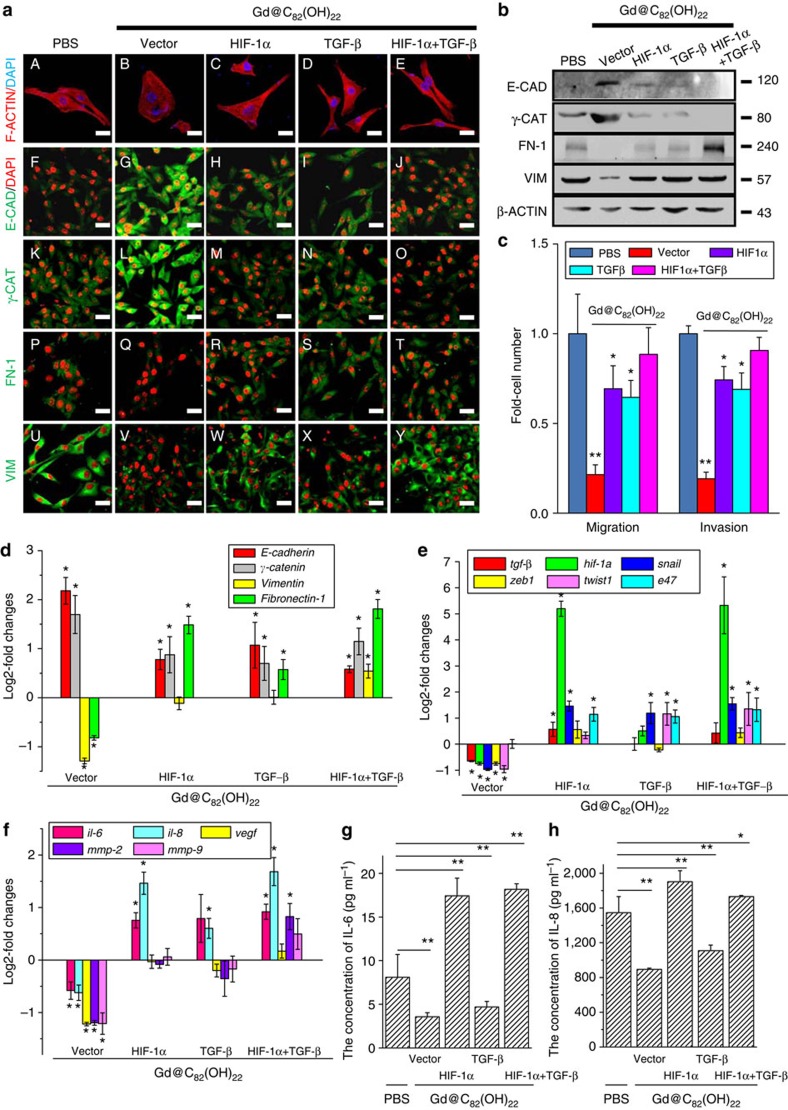
Gd@C82(OH)22 impaired EMT by inhibition of TGF-β and HIF-1α expression under hypoxia.MDA-MB-231 cells were transfected with hif-1α expressing plasmid and/or treated with 20 ng ml−1 TGF-β with further culture in the presence of Gd@C82(OH)22 or PBS under hypoxia for 10 days. (a; A-E) F-ACTIN cytoskeleton of cells (scale bar, 12.5 μm). Immunofluorescence staining (a, F-Y) and western blot analysis (b) of E-CADHERIN (E-CAD), γ-CATENIN (γ-CAT), VIMENTIN (VIM) and FIBRONECTIN-1 (FN-1). Scale bar, 25 μm. (c) The migratory and invasive cells were examined using trans-well cell culture chambers and Matrigel-coated ones (mean±s.e.m., n=3 each). *P<0.05 and **P<0.01 (two-way ANOVA, Bonferroni’s post-hoc test). mRNA levels of EMT markers (d), hif-1α, hif-1β, tgf-β, snail, zeb1, twist1, e47 (e), il-6, il-8, mmp-2, mmp-9 and vegf (f) were analysed by qPCR (mean±s.e.m., n=3 each). ELISA analysis for expression of IL-6 (g) and IL-8 (h) in the MDA-MB-231 cell culture medium was determined. All the data are represented as mean±s.e.m. (n=3 each) with *P<0.05 and **P<0.01 (two-way ANOVA, Bonferroni’s post-hoc test).